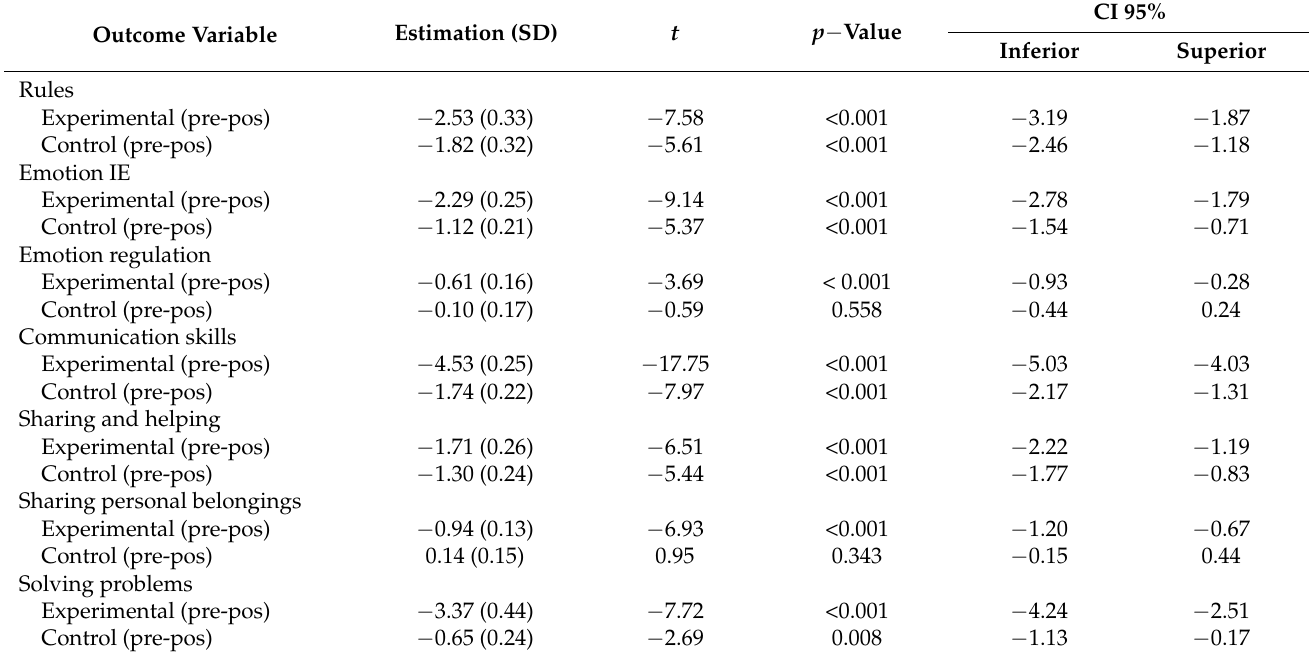
Table 5. Pairwise contrast of the group*time interaction, using means estimated by the model on the program’s variables. Outcome